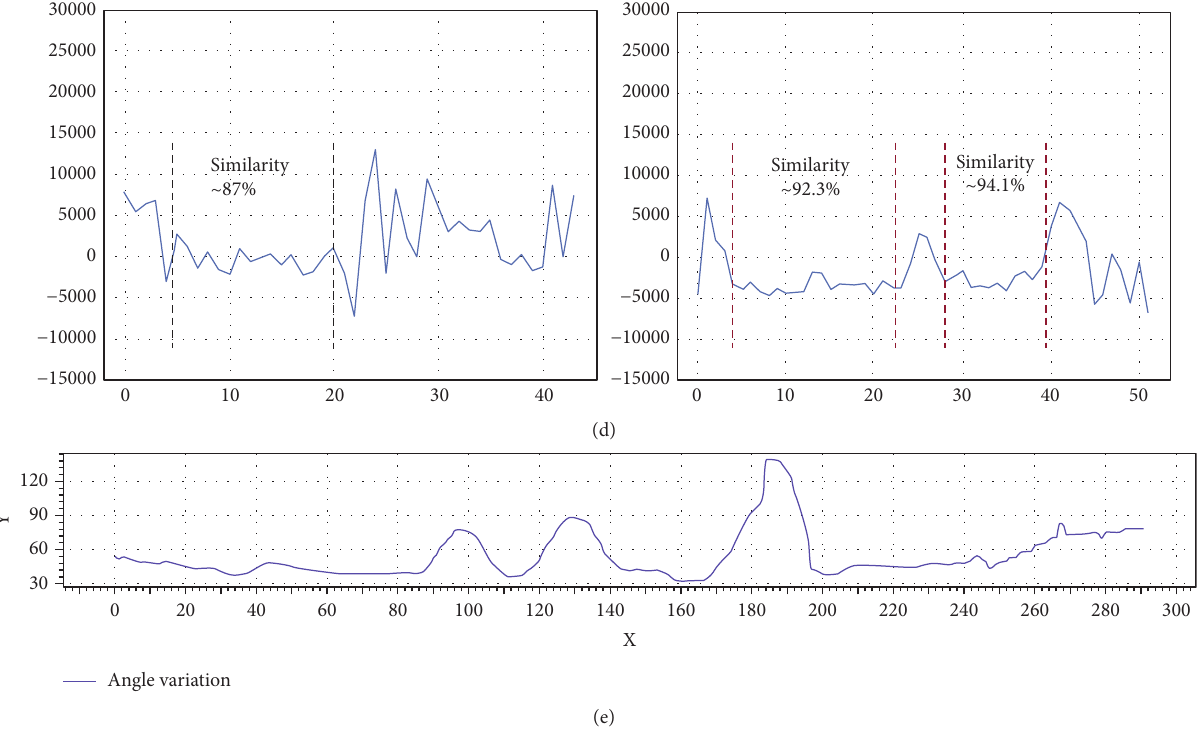
Figure 8: Testing on real-time dataset. (a) Testing on real-time dataset to visualize crucial gait patterns of angles. (b) Graphical plot of (a) of knee angles and their motions. (c) Gait silhouettes of (a), isolating the background to extract gait parameters. (d) Trained parameters (A) and testing parameters (B). Gait parameters tested were body posture (backbone motion). (e) Knee angle variation of subject presented in